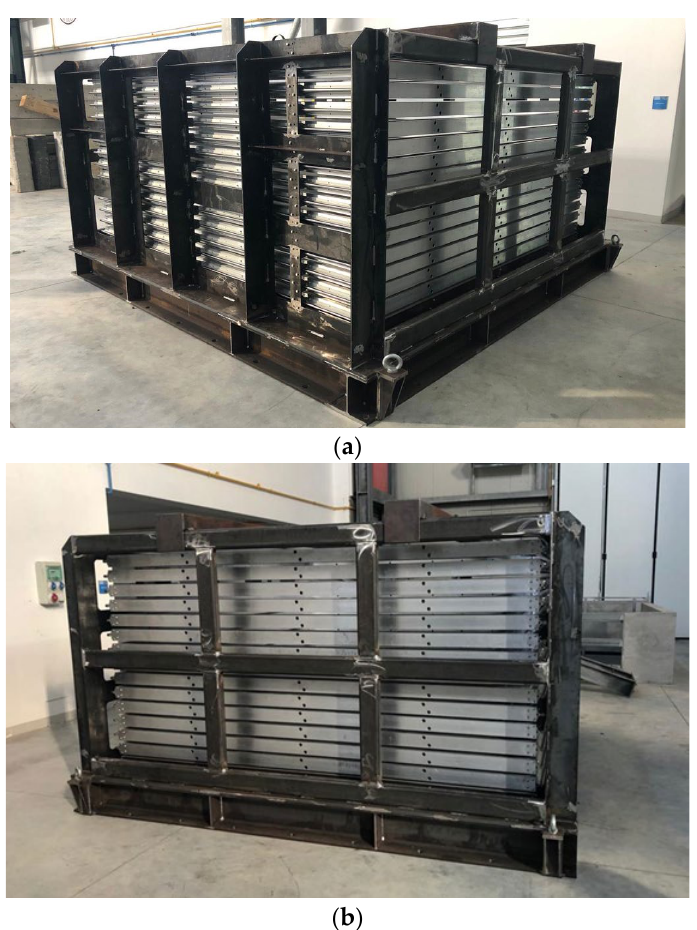
Figure 24. Laminar shear box at the Laboratory of Earthquake engineering and Dynamic Analysis (L.E.D.A.).